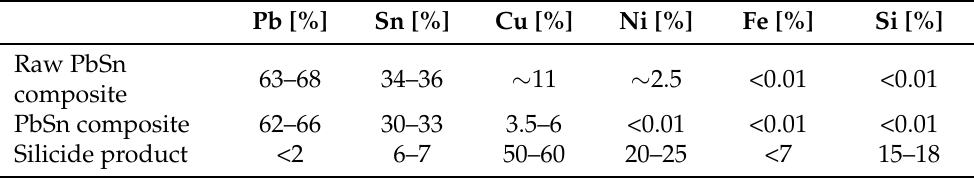
Table 7. Average composition of crude PbSn composite, silicide product, and PbSn